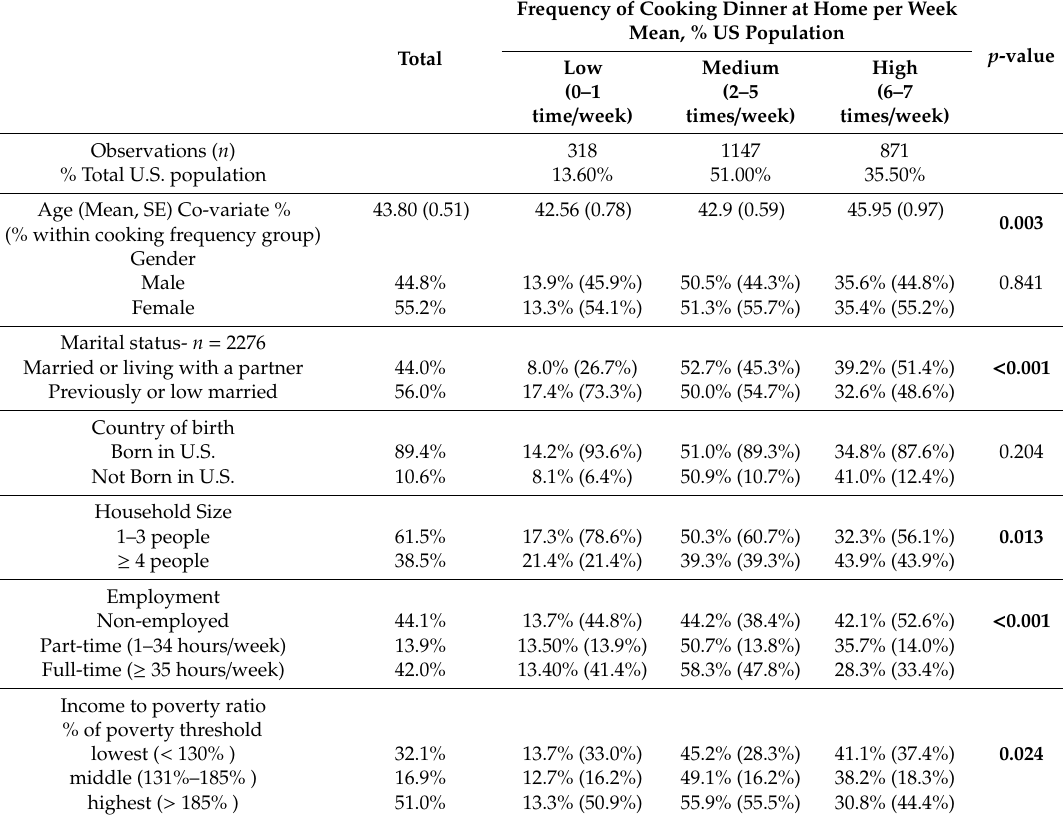
Table 1. Characteristics for sample population of Non-Hispanic Black adults, age ≥ 19 years: NHANES, 2007–2010. (observations = 2336; weighted population 24,949,641).